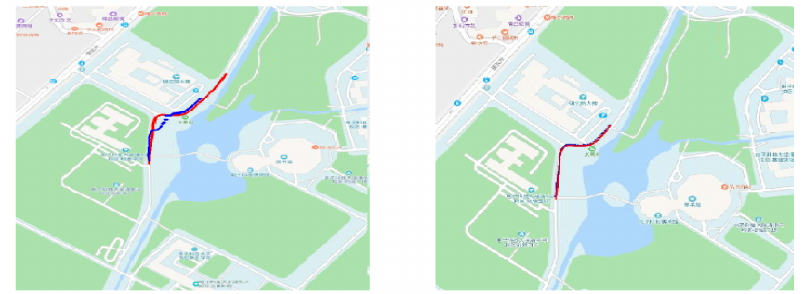
Figure 9. On-campus location results.